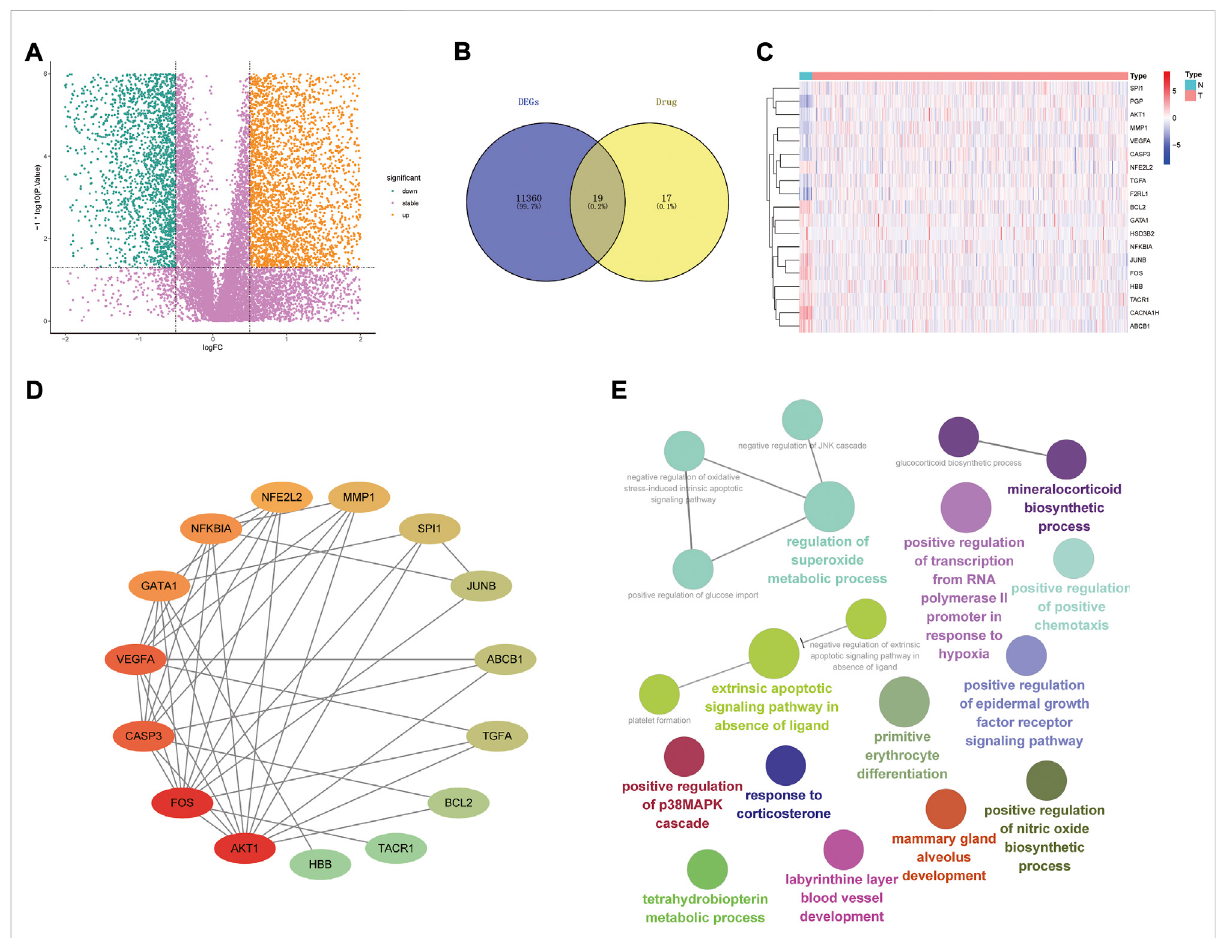
FIGURE 2 Interaction relationship and enrichment analysis of drug-associated differential genes; (A) Volcanoes of 6,989 endometrial cancer differential genes; (B) Venny diagram of 19 drug-associated differential genes; (C) Heat map of 19 drug-differential genes (N represents normal group, T represents tumor group; red represents high gene expression, blue represents low gene expression, the depth of colour represents high or low expression); (D) PPIproteininteractionnetworkrelationshipdiagramofDR-DEGs(redrepresentshighlevelofinteraction,greenrepresentslow level of interaction; (E) Analysis of the enrichment effect of